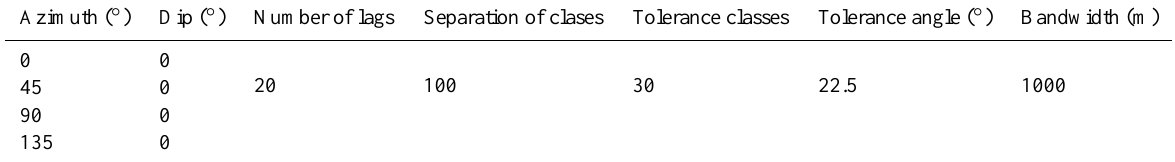
Table 1. General variogram analysis.